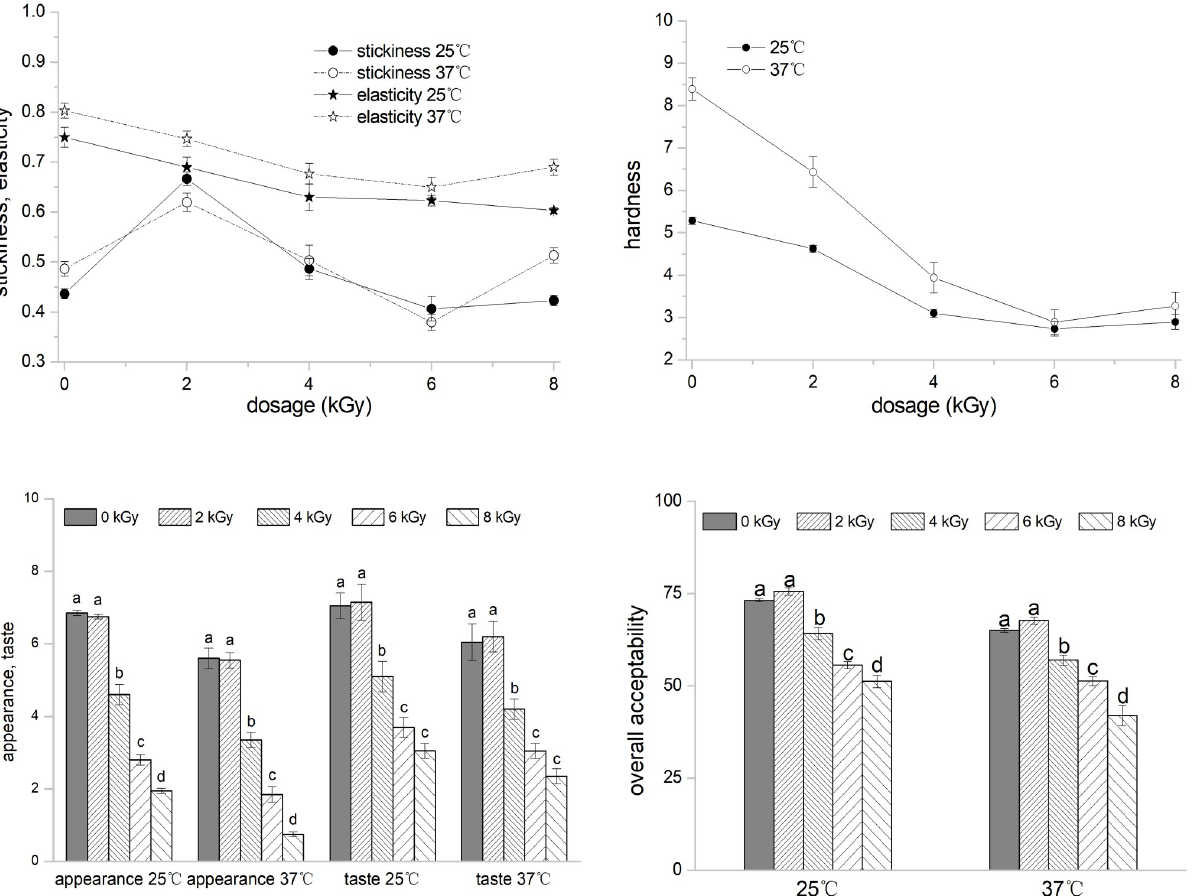
Fig 4. Effects of EBI on the sensory qualities of cooked rice stored for 75 days at 25 ˚C and 37 ˚C. Different letters/numbers above the bar indicate significant differences at p < 0.05. Error bar represents standard deviation ( n = 3).